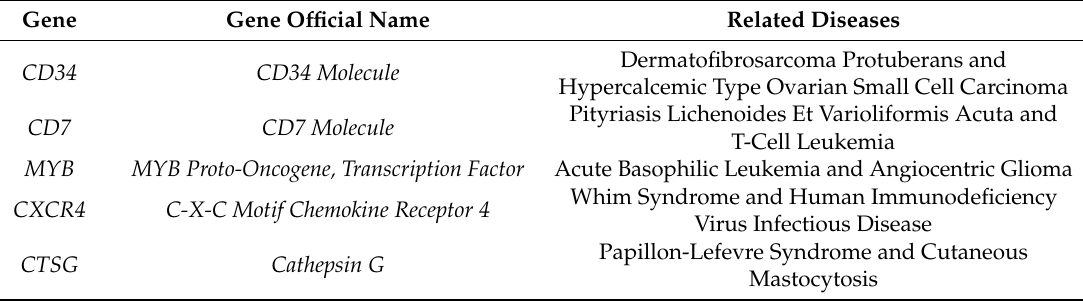
Table 3. The top five genes selected by LJELSR for the ALL_AML